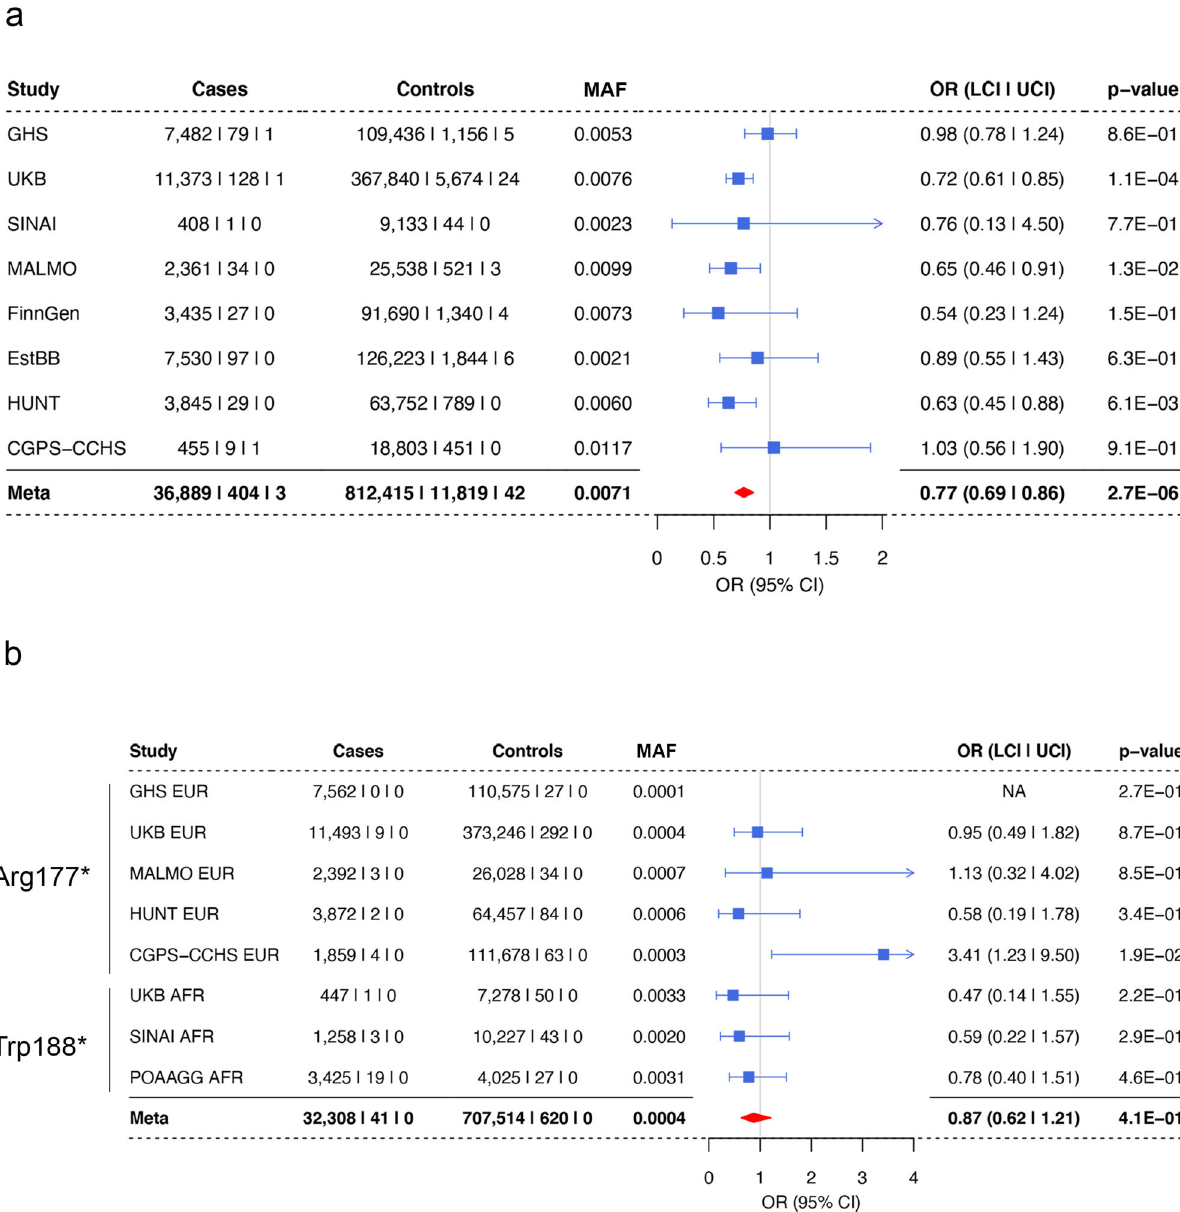
Fig. 3 Association of ANGPTL7 variants with glaucoma. a Meta-analysis results for Gln175His with glaucoma across 8 different cohorts. b Cross-ancestry meta-analysis of Arg177* and Trp188* across 5 European (EUR) and 3 African (AFR) ancestry cohorts. The variants in the meta-analysis of EUR and AFR cohorts were Arg177* and Trp188*, respectively. GHS Geisinger DiscovEHR, UKB UK Biobank, SINAI Mt. Sinai Medical School BioMe Biobank, MALMO Malmö Diet and Cancer Study, EstBB the Estonia Biobank at the University of Tartu, HUNT the HUNT study from Nord-Trøndelag, CGPS-CCHS the Copenhagen General Population Study and the Copenhagen City Heart Study, POAAGG Primary Open Angle African-American Glaucoma Genetics, MAF Minor allele